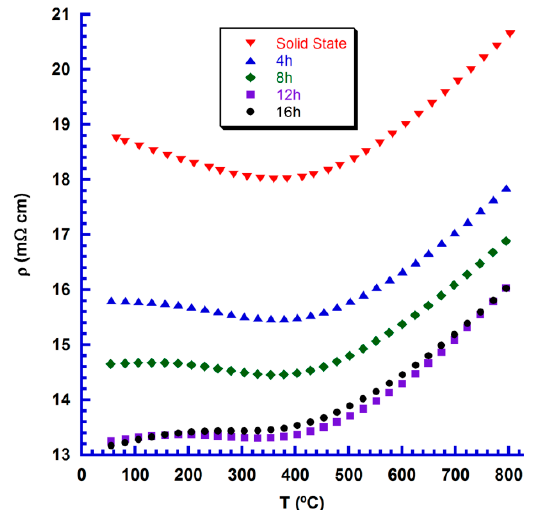
ff erent Ca 3 Co 4 O 9 + δ